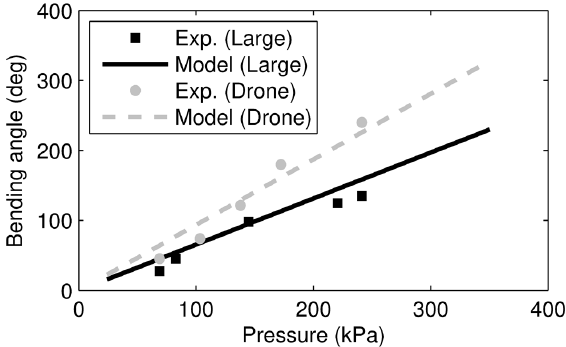
Figure 5. Modeled and experimental bending of bending actuators at various actuation pressures.